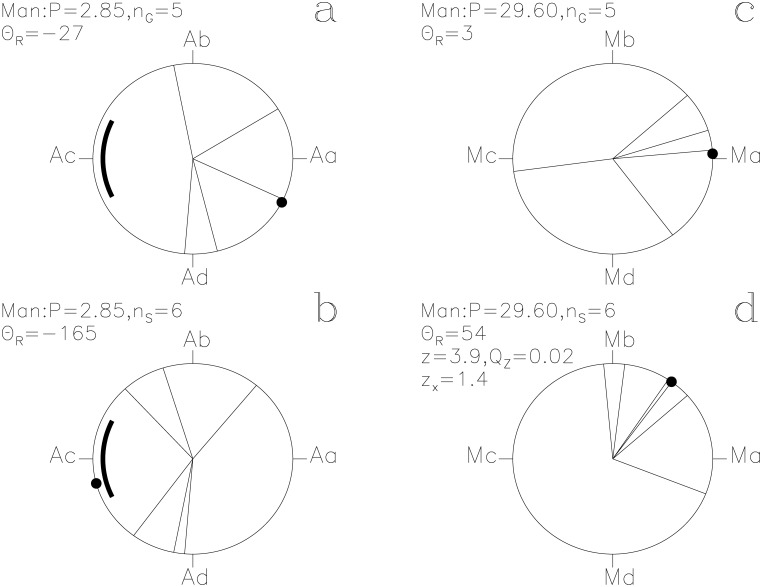
Man.otherwise as in Fig 1